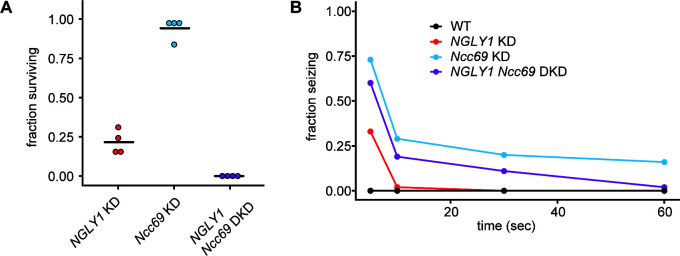
NGLY1 and Ncc69 interact genetically in Drosophila.(A) Proportion of flies surviving to eclosion in ubiquitous knockdowns. NGLY1 knockdown (KD) are UAS-PnglRNAi/+; Tubulin-GAL4/+. Ncc69 KD are UAS-Ncc69RNAi/+; Tubulin-GAL4/+. NGLY1 Ncc69 double knockdown (DKD) are UAS-PnglRNAi/+ UAS-Ncc69RNAi/Tubulin-GAL4/+. Four separate matings were performed for each cross with at least 40 offspring generated for the balancer control for each. Fraction surviving is calculated compared to balancer offspring. Chi-square analysis was performed for the total number of flies compared to expected Mendelian numbers. NGLY1 KD χ2 = 109.7, p<0.0001; Ncc69 KD χ2 = 1.002, p=0.3168, and NGLY1 Ncc69 DKD χ2 = 186, p<0.0001. (B) Bang sensitivity assay to assess seizures in glial knockdown flies. WT flies are attP2 and attP40. NGLY1 KD are UAS-PnglRNAi/+; repo-GAL4/+. Ncc69 KD are UAS-Ncc69RNAi/+; repo-GAL4/+. NGLY1 Ncc69 DKD are UAS-PnglRNAi/+; UAS-Ncc69RNAi/ repo-GAL4. For each genotype, at least 45 4- to 7-day-old females were used to calculate the percent seizing at a given time after vortexing. Repeated measures ANOVA p-value=0.000176.